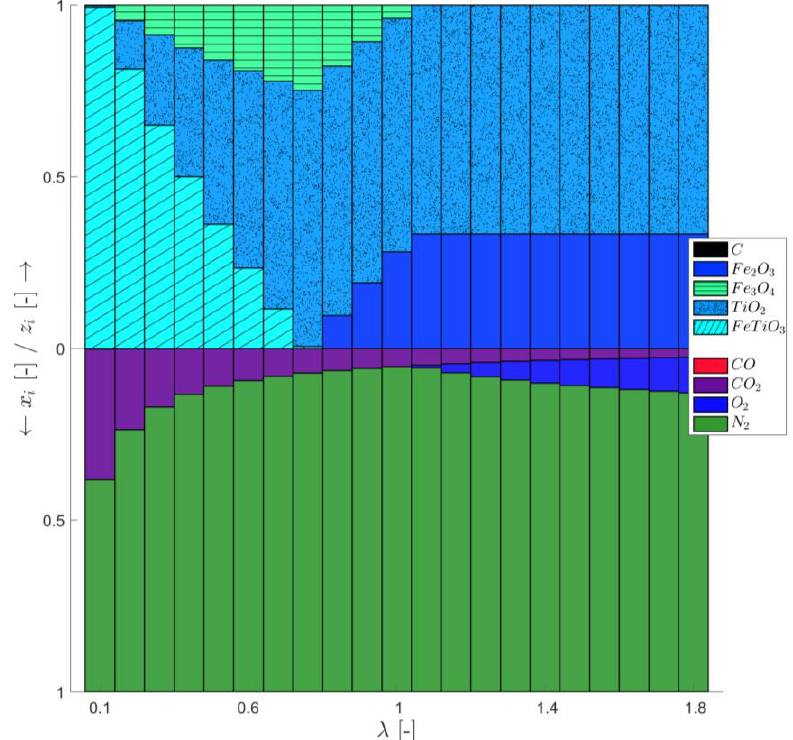
Figure A2. Solid and gas composition at chemical equilibrium for TAR = 1000 ◦ C at varying air-to-fuel equivalence ratio λ (Inlet solid composition: 78 mole-% FeTiO 3 , 6 mole-% Fe 2 O 3 and 11 mole-% TiO 2 ).